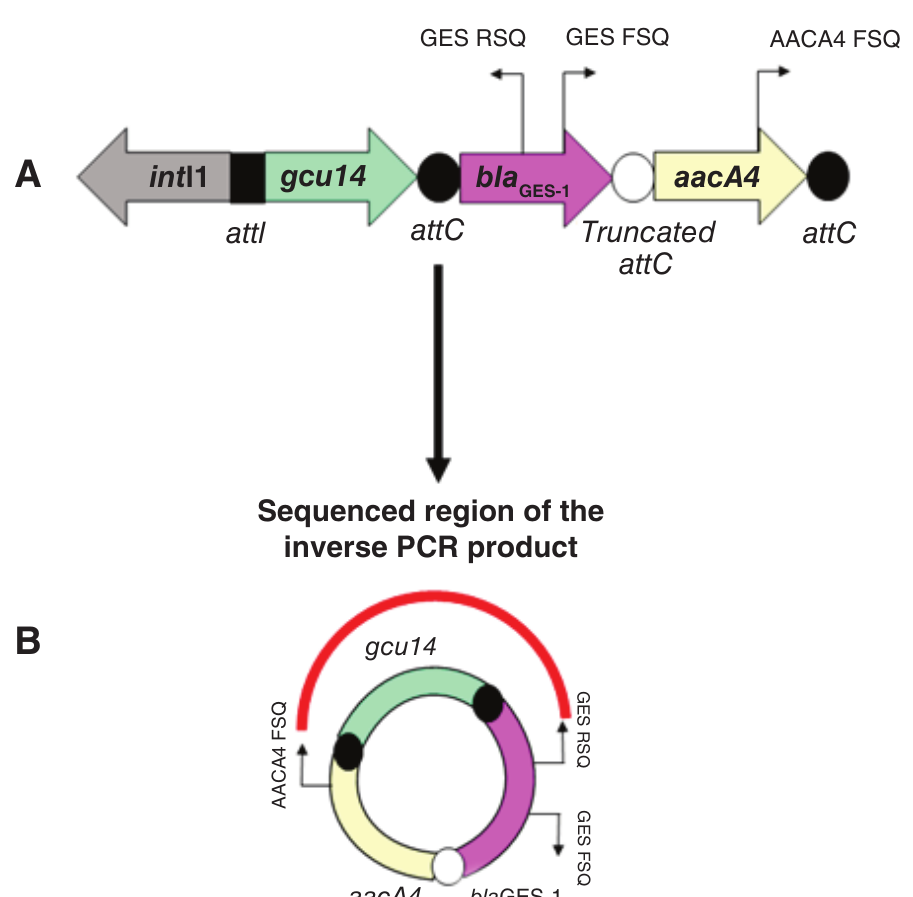
Figure 3. Schematic representation of the free circular form cassette array resulted from the inverse PCR assay. ( A ) inserted/linearized form of integron harbouring the fused cassettes. Arrows show the gene transcription orientation. Thin arrows represent the annealing sites of the inverse PCR and sequencing primers whose generated product corresponded to the cassette circular form illustrated in ( B ). ( B ) Illustration of the free circular form of gene cassettes represented in ( A ). Thin arrows show the primers used to obtain the inverse PCR product (GES FSQ and GES RSQ) and the primers used in sequencing (AACA4 FSQ and GES RSQ) that revealed the excision in block of the entire gene cassette arrangement ( gcu14 - bla / aacA4 ) from integron (red curved GES-1